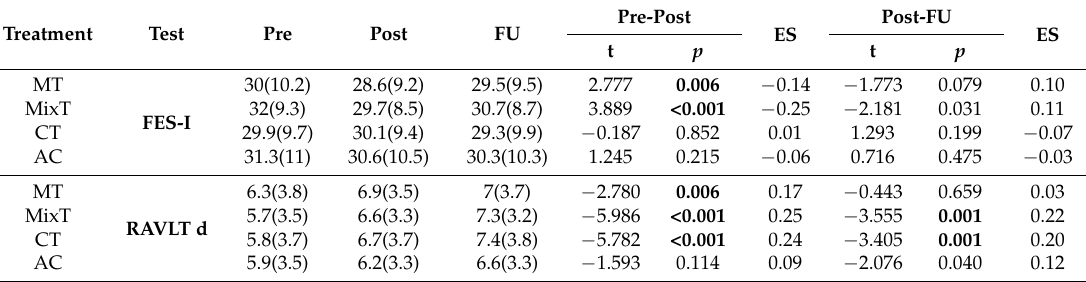
Table 3. Post-hoc results for significant